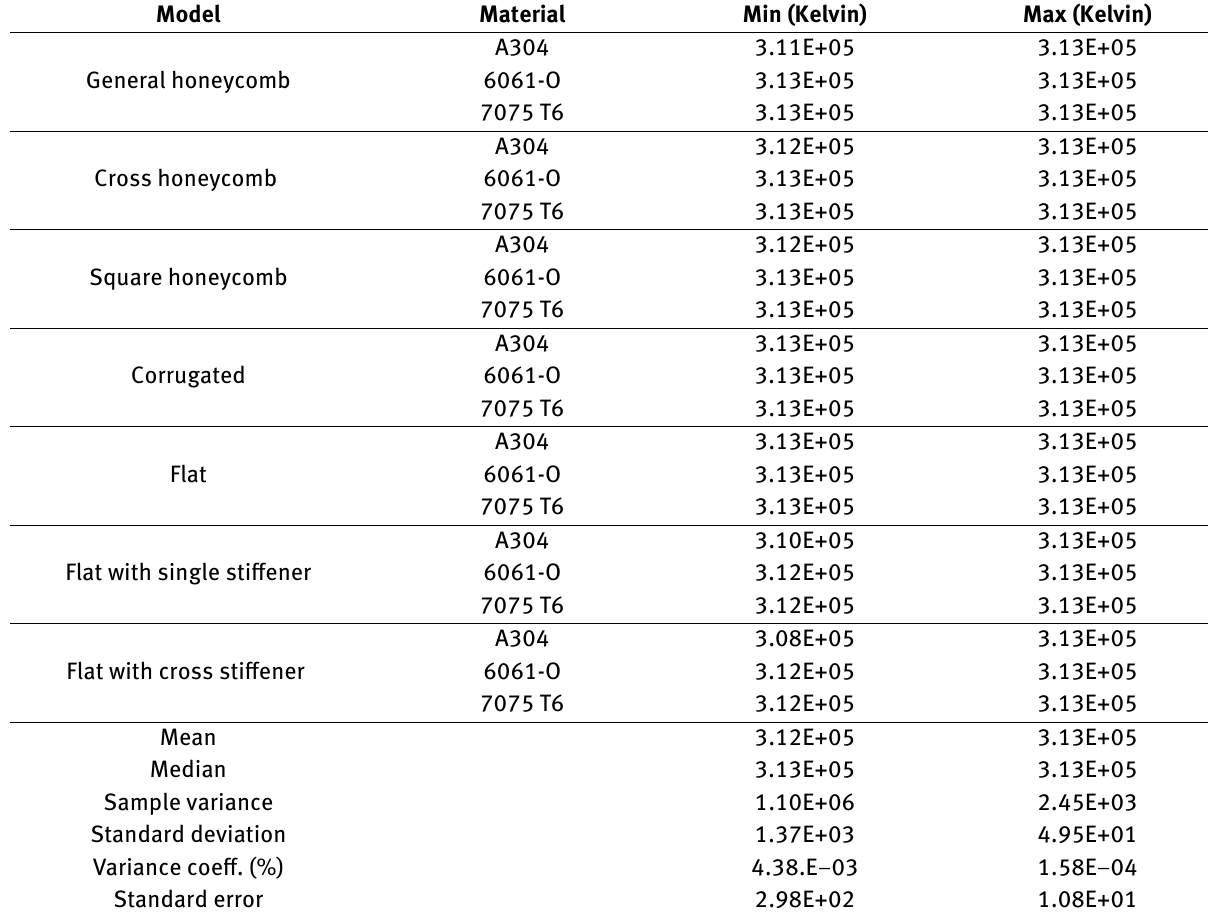
Table 10: Summary of the thermal simulation results based on the model variations